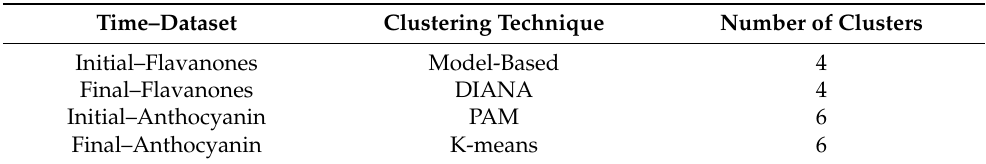
Table 3. Parameters associated with the clustering techniques applied to the datasets of the work, selected by ClValid